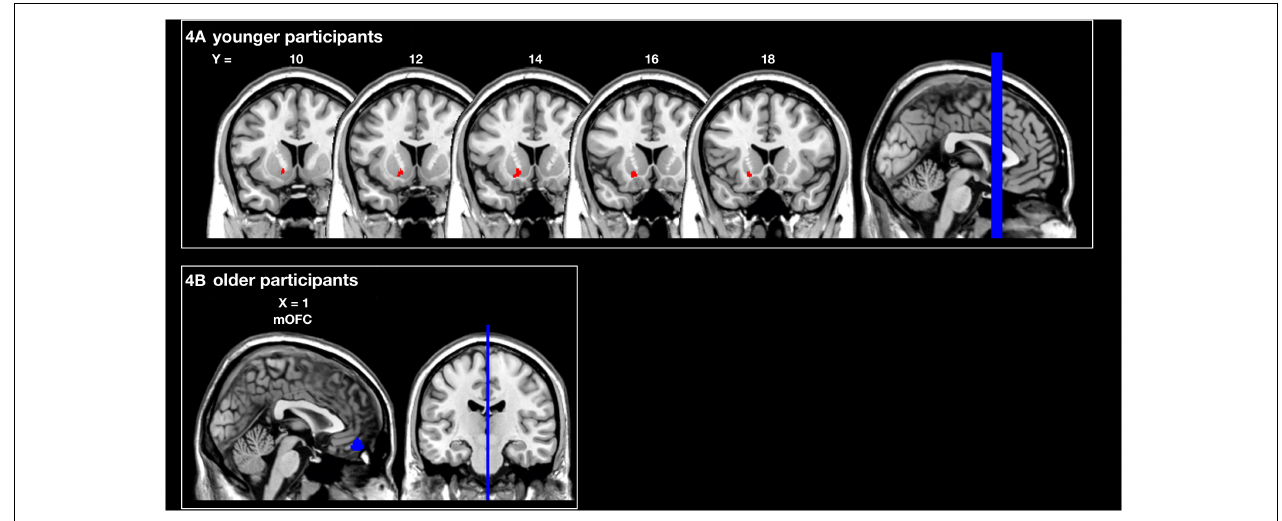
FIGURE 4 | Region of interest (ROI) analysis of grey matter volume (GMV) differences between subjects grouped according to their reward-related motor performance (operationalized as the percentage of rewarded trials; third vs. first tercile). (A) Motor performance related to monetary reward (red) in young participants: left striatum (putamen). (B) Motor performance related to social reward (blue) in older participants: medial orbitofrontal cortex (mOFC). Displayed voxels survive FWE-correction within the ROIs (all p SVC < 0.05). All images are displayed on coronal (A) and sagittal (B) slices of the standard brain provided by MRIcron in neurological convention. x - and y -coordinates refer to the MNI-space (SVC, small volume corrected). TABLE 1 | Brain regions showing larger grey matter volumes associated with motor performance related to monetary/social reward and procedural learning. Brain region Hemisphere MNI coordinates x y z Peak z -score Cluster size